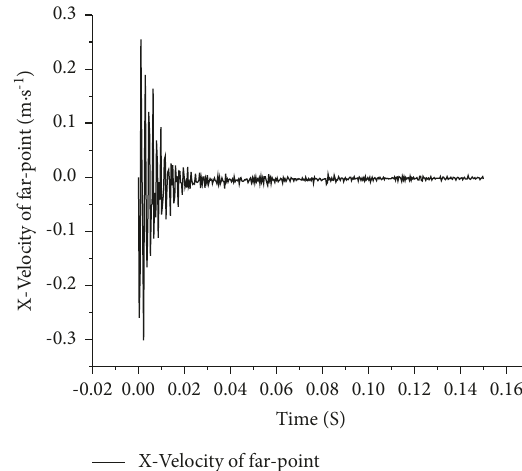
Figure 10: X-vibration time course of near point at arch waist.